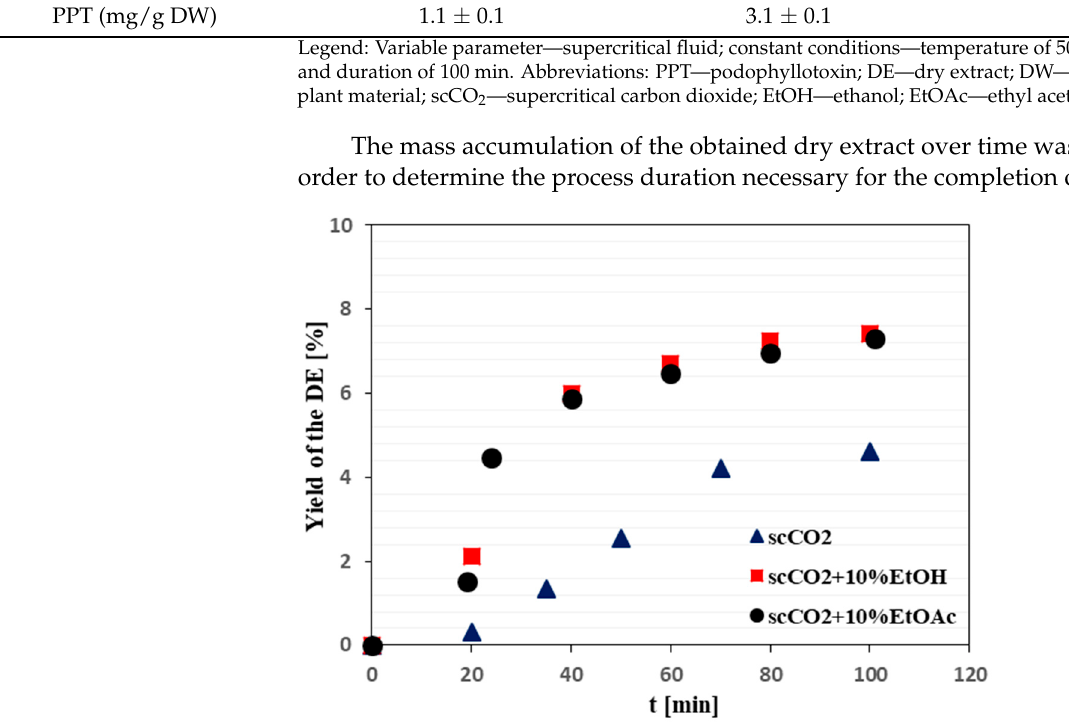
DE—dry extract; scCO 2 —supercritical carbon dioxide; EtOH—ethanol; EtOAc—ethyl acetate. The